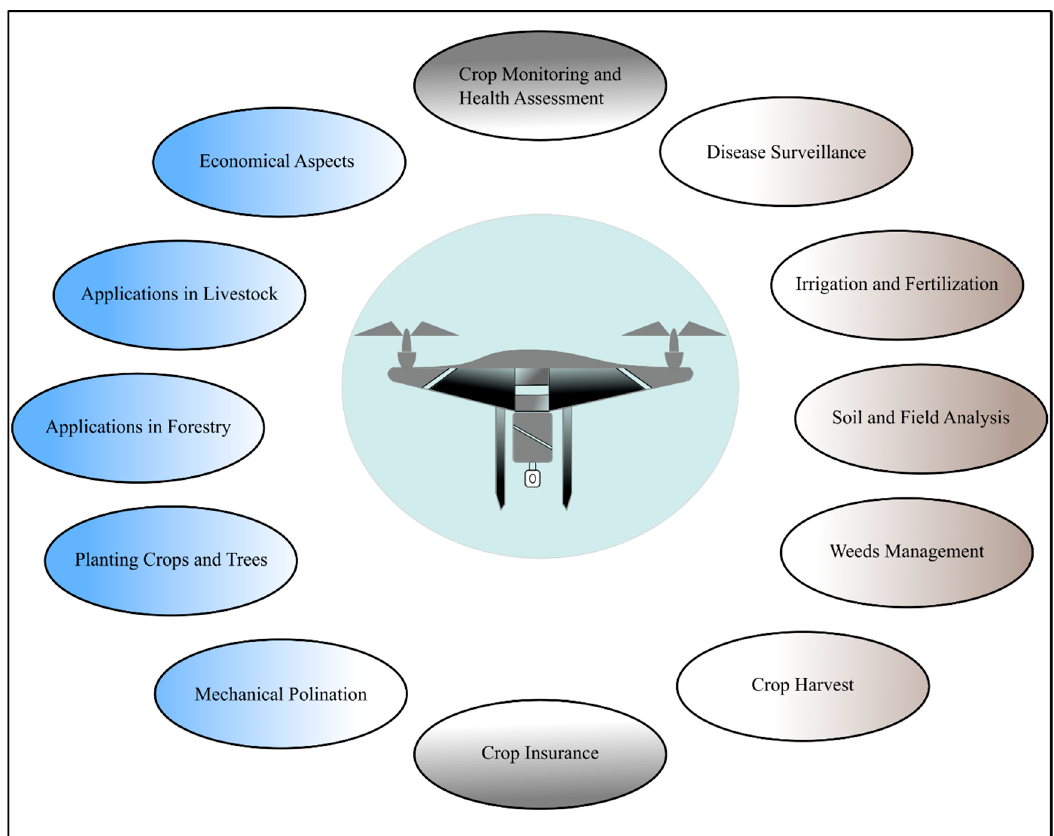
Figure 8. A schematic diagram of the applications of drones in agriculture.